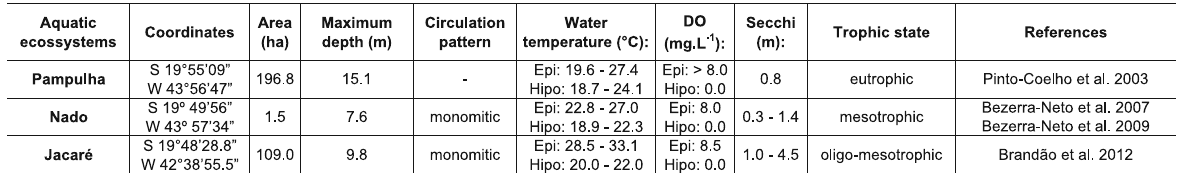
Characteristics of Pampulha, Nado and Jacaré